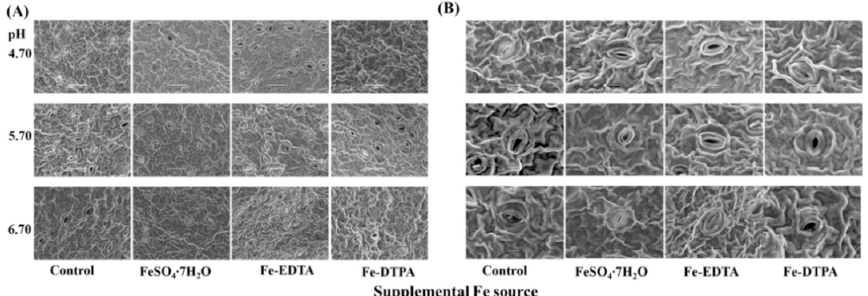
Figure 5. The SEM images of leaf stomata of S. commixta after 6 weeks of culture. Bars indicate 50 µ m ( A ) and 10 µ m ( B ).